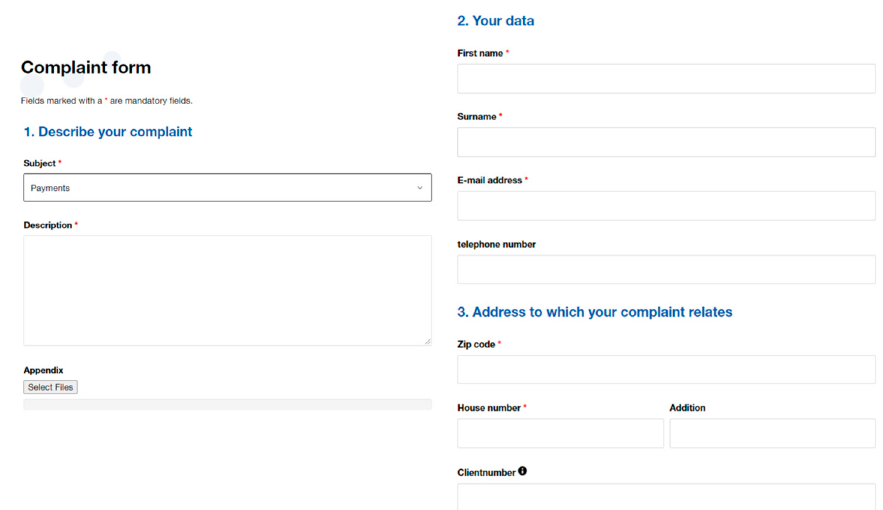
Figure A1. An example of a complaint form designed by the WBG for collecting customer complaints (adapted from the website of WBG: https://waterbedrijfgroningen.nl/, accessed on 17 December 2021). Subject categories include payment, water meter reading, water meter replacement, malfunction, construction of main lines, moving houses, maintenance, connections, and planned projects.